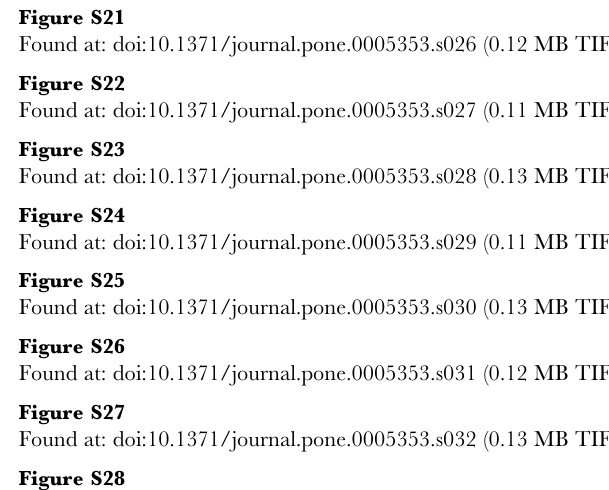
Figure 4. Mass spectrometry profiles of the subject’s serum sample after subcutaneous injection of rhGM-CSF. A) A mass spectrometry profile of the serum sample after subcutaneous injection of rhGM-CSF at 0 h. B) A mass spectrometry profile of one subject’s serum sample after 3 h of the subcutaneous injection of rhGM-CSF. The arrow indicates the differential point between A and B. C) Amino acid sequence determined by EPI analysis corresponding to the differential point in the subject’s serum sample after 3 h of the subcutaneous injection of rhGM-CSF in comparison to the hGM-CSF sequence. The TM sequence in the pane is the amino acid sequence corresponding to the differential point. Figure S4 Found at: doi:10.1371/journal.pone.0005353.s009 (0.11 MB TIF) Figure S5 Found at: doi:10.1371/journal.pone.0005353.s010 (0.13 MB TIF) Figure S6 Found at: doi:10.1371/journal.pone.0005353.s011 (0.11 MB TIF) Figure S7 Found at: doi:10.1371/journal.pone.0005353.s012 (0.11 MB TIF) Figure S8 Found at: doi:10.1371/journal.pone.0005353.s013 (0.11 MB TIF) Figure S9 Found at: doi:10.1371/journal.pone.0005353.s014 (0.12 MB TIF) Figure S10 Found at: doi:10.1371/journal.pone.0005353.s015 (0.11 MB TIF) Figure S11 Found at: doi:10.1371/journal.pone.0005353.s016 (0.12 MB TIF) Figure S12 Found at: doi:10.1371/journal.pone.0005353.s017 (0.12 MB TIF) Figure S13 Found at: doi:10.1371/journal.pone.0005353.s018 (0.12 MB TIF) Figure S14 Found at: doi:10.1371/journal.pone.0005353.s019 (0.12 MB TIF) Figure S15 Found at: doi:10.1371/journal.pone.0005353.s020 (0.13 MB TIF) Figure S16 Found at: doi:10.1371/journal.pone.0005353.s021 (0.10 MB TIF) Figure S17 Found at: doi:10.1371/journal.pone.0005353.s022 (0.13 MB TIF) Figure S18 Found at: doi:10.1371/journal.pone.0005353.s023 (0.11 MB TIF)